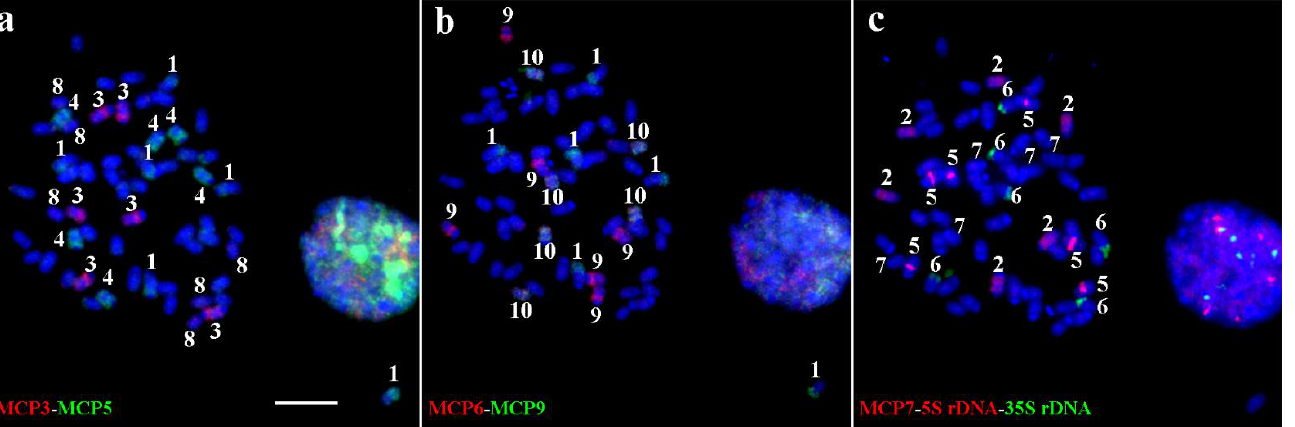
Figure 4. Sequential oligo-FISH identifying all 10 chromosomes on the same metaphase plate of T. arundinaceum . ( a ) First round of FISH using MCP3 (digoxigenin-red) and MCP5 (biotin-green) probes. ( b ) Second round of FISH using MCP6 (digoxigenin-red) and MCP9 (biotin-green) probes. ( c ) Third round of FISH using MCP7 (digoxigenin-red), 5S rDNA (digoxigenin-red), and 35S rDNA (biotin-green) probes. Arabic numerals denote the chromosome numbers. Bar = 10 µ m. Table 2. Chromosome length and arm ratio of mitotic metaphase chromosomes of T. arundinaceum .